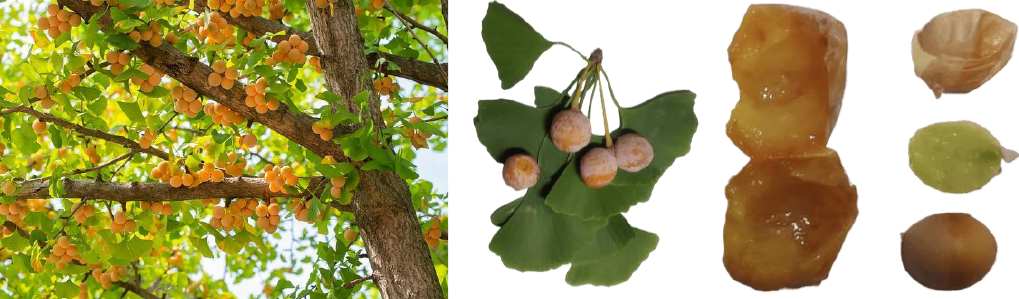
Figure 1. ( left ) Ginkgo biloba tree bearing ripe, fruit-like sarcotestae; ( center ) close-up of leaves and sarcotestae; ( right ) fleshy seedcoat (sarcotesta) and seed (sclerotesta). Ginkgo biloba is a widely used plant remedy throughout the world [1]. Its potential benefits for cardiovascular and neurodegenerative diseases have been substantiated [2,3]. and cardiovascular diseases, though research in this area is limited [4].